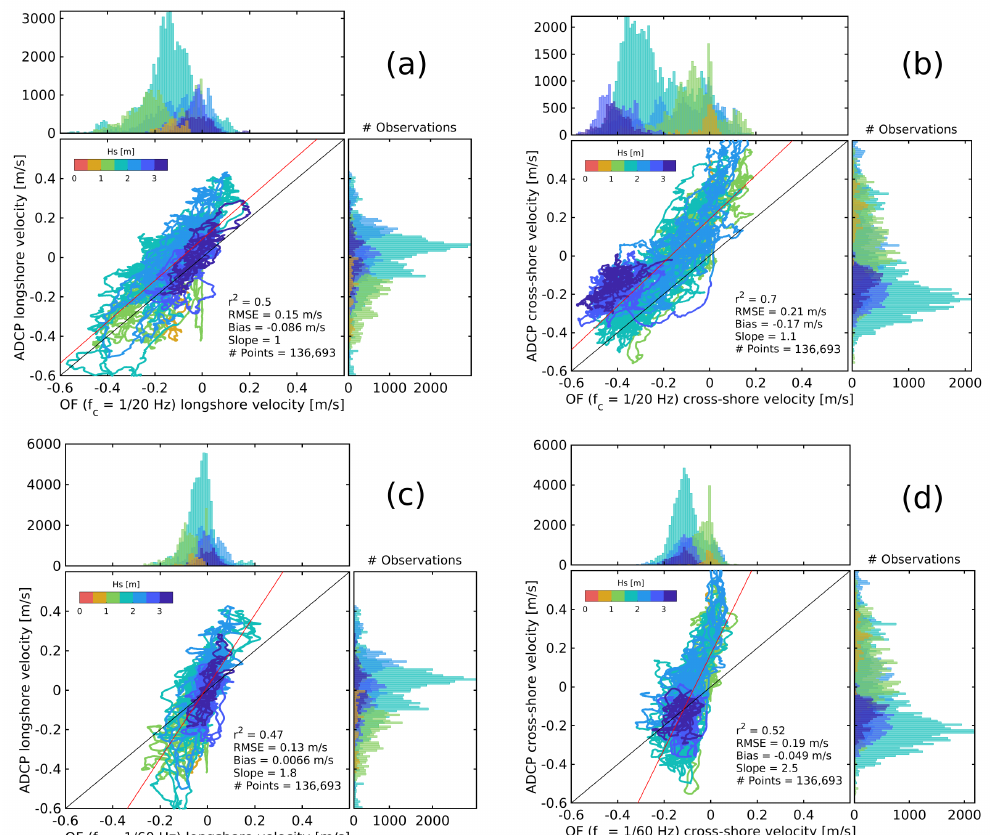
Figure 6. Five minute time-averaged ADCP vs. optical flow surface velocity components from 8 to 15 October 2018 under different wave height conditions during low tide when the ADCP is located inside the surf zone. ADCP surface velocity measurements (average between σ 19 , σ 20 and σ 21 ) are compared against optical flow velocity estimates computed from low-pass filtered images with ( a , b ) f c = 1/20 Hz and ( c , d ) f c = 1/60 Hz. The colors denote the velocities associated with different ranges of offshore significant wave height H s . The red line indicates the linear regression and the black line the 1:1 perfect match. Positive cross-shore (longshore) surface velocities values correspond to an offshore-directed (directed away from the headland)